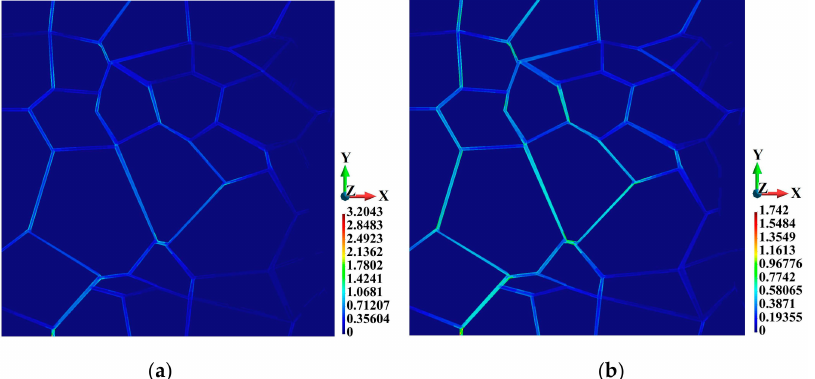
Figure 10. Equivalent plastic strain (non-dimensional), top view: ( a ) Adiabatic solution; ( b ) coupled solution.